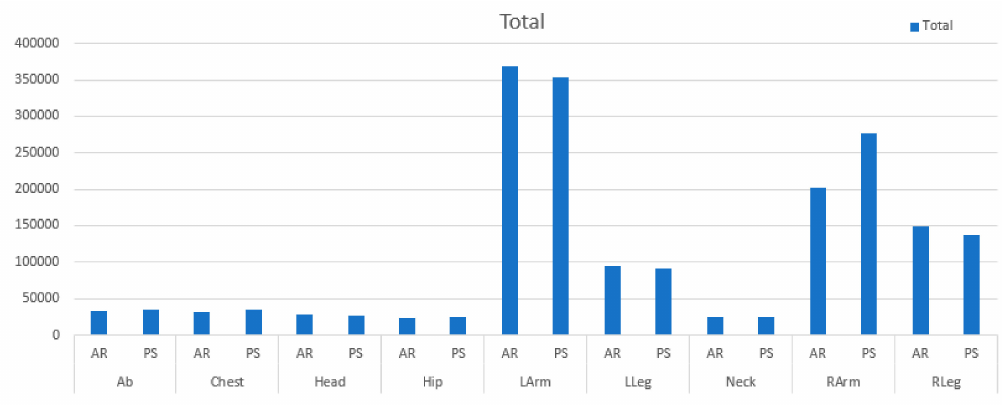
Figure 8. Device-based comparison of raw and filtered data for di ff erent body